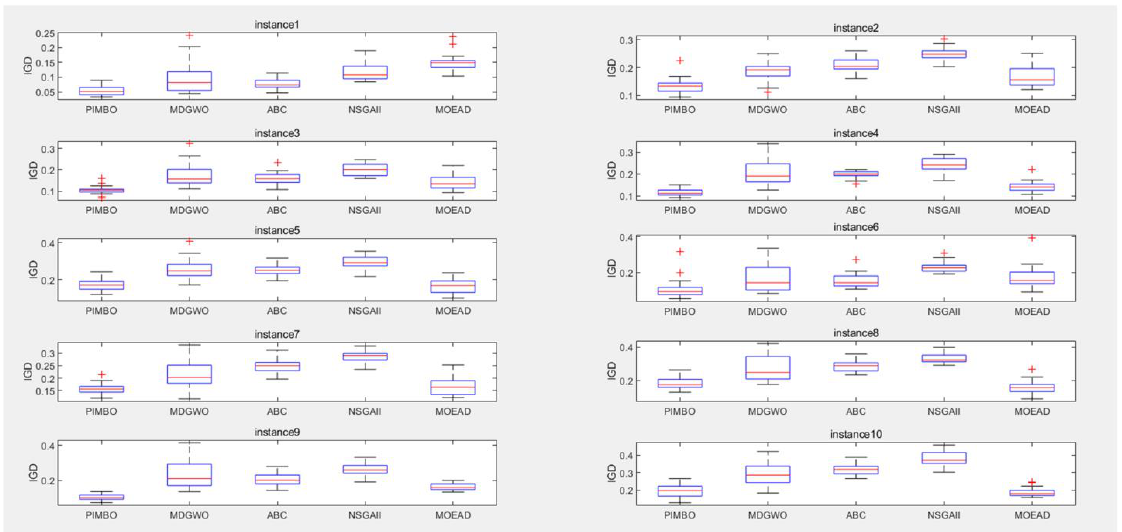
Figure A7. AND/OR graph of a radio set.